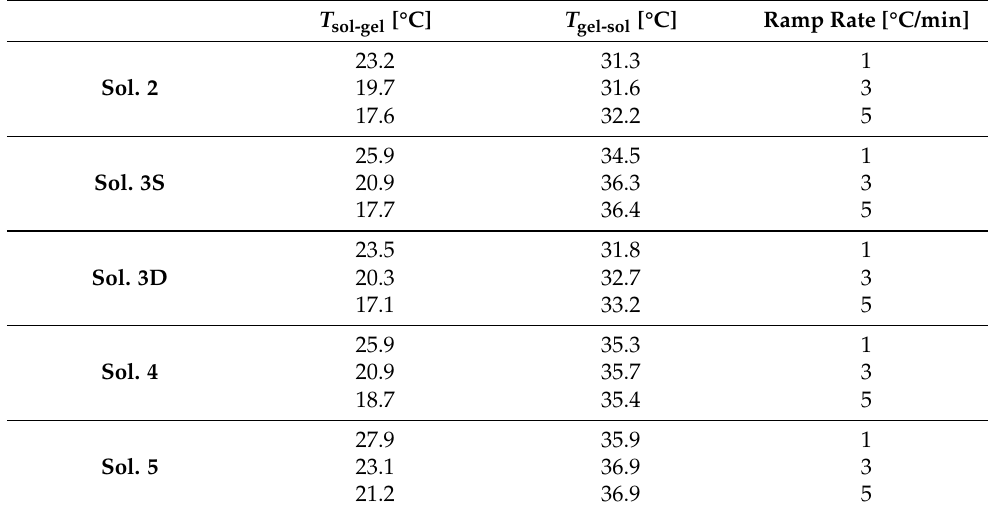
Table 2. Characteristic transition temperatures of the investigated solutions at different ramp